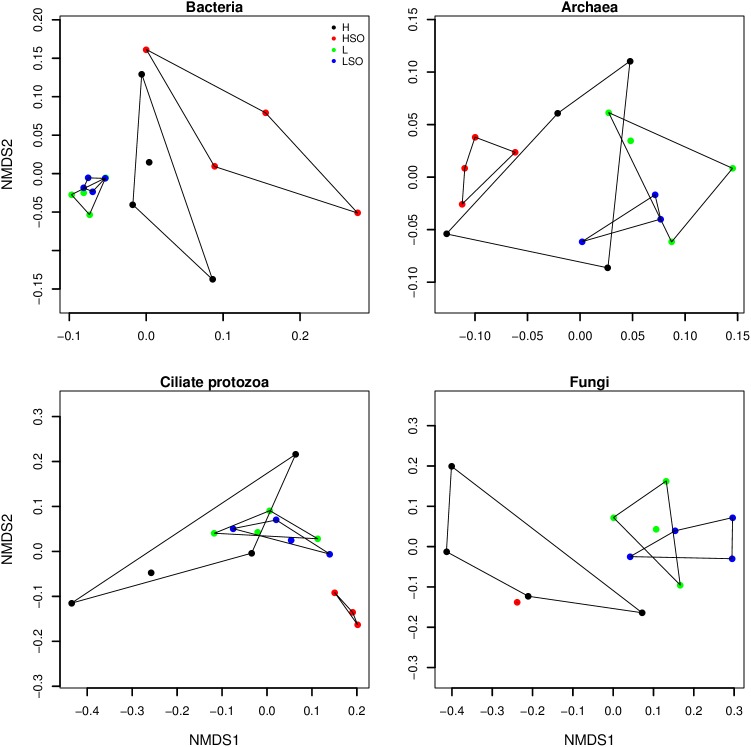
NMDS plots of bacteria, archaea, ciliate protozoa and fungi, based on amplicon sequence data.Individual animals are represented by dots, colored based on the diet: high (H—black) or low (L—green) proportion of concentrates without oil, or supplemented with SO (HSO–red, and LSO—blue).